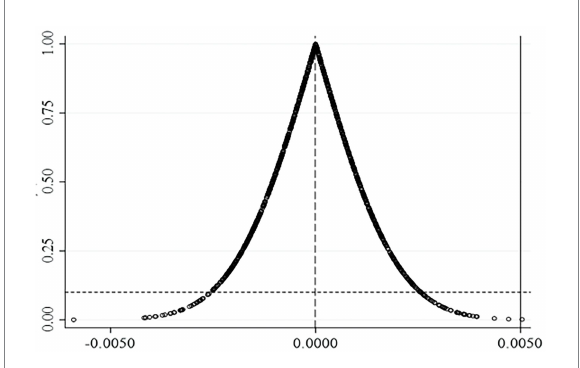
TABLE 10 Sample regression results of different life cycle